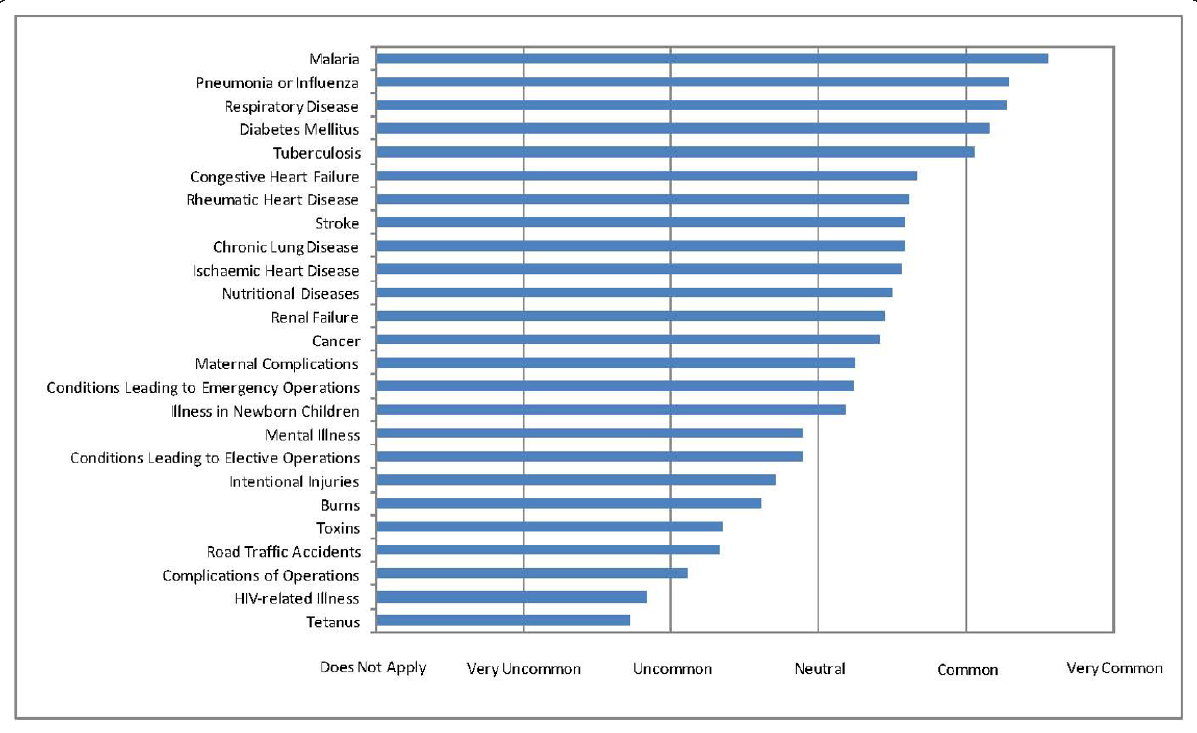
Figure 1 Conditions leading to the treatment of critical illness